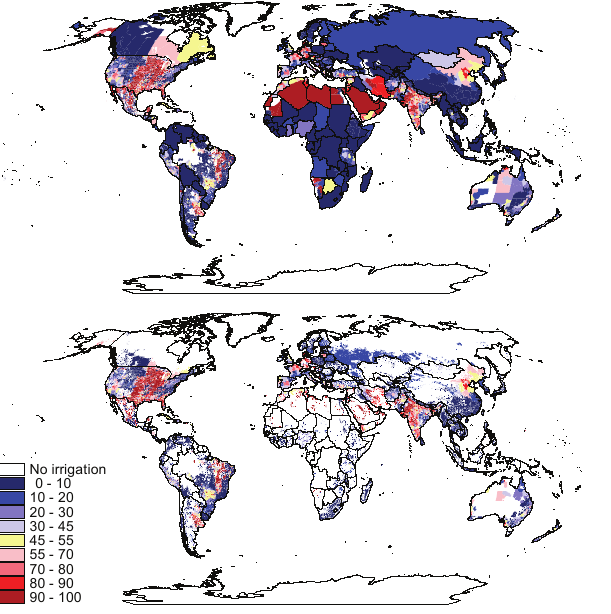
Fig. 2. Percentage of area equipped for irrigation that is irrigated with groundwater per statistical unit (top) and per irrigated grid cell in version 4 of the global map of irrigation areas (Siebert et al., 2006; bottom; see the electronic Supplement for a high resolution version of this figure).